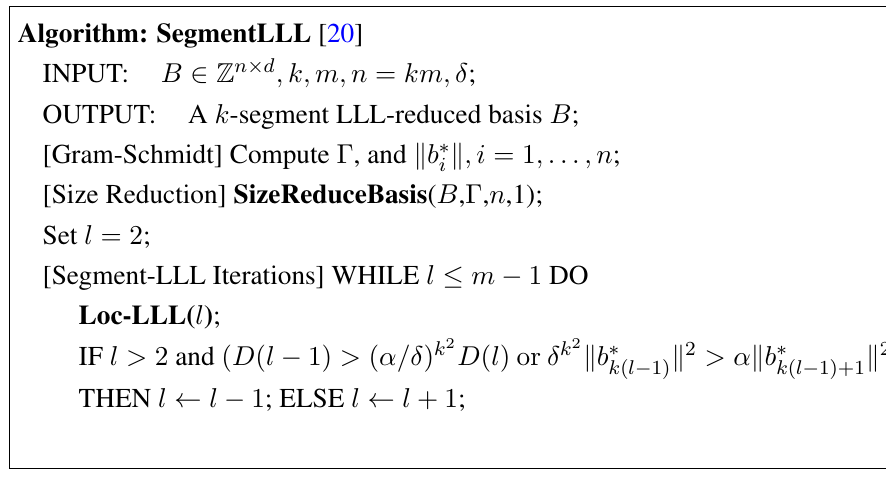
Figure 10. The Segment LLL Basis Reduction